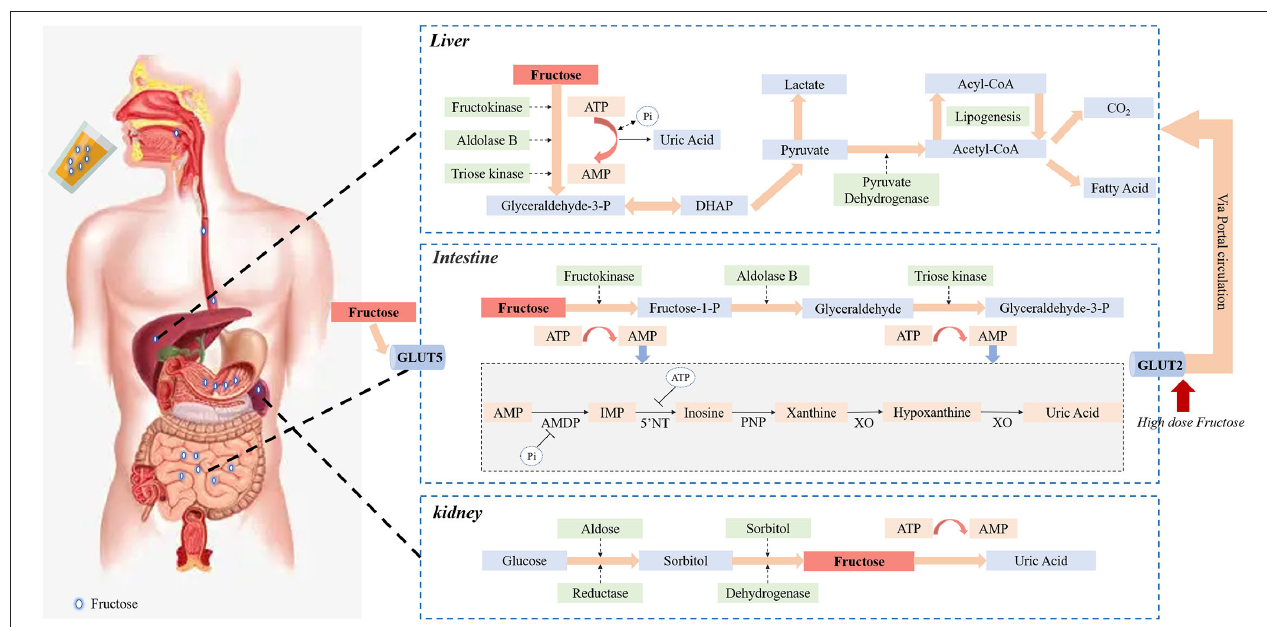
FIGURE 1 | Fructose metabolism in the body. The fructose ingested by the body will be first transported to the enterocyte via GLUT5, and then absorbed and metabolized in an insulin-independent manner. Through all the processes of metabolism in the small intestine, uric acid is produced. The rapid phosphorylation of fructose into fructose 1-phosphate requires ATP to provide a phosphate molecule, which reduces intracellular levels of ATP, GTP, and phosphate, leading to the accumulation of AMP and activation of AMP deaminase. AMP generates IMP under the action of AMP deaminase. IMP levels are elevated, which is metabolized with GMP to produce uric acid. Uric acid, in turn, inhibits AMP-activated protein kinases, which promotes more AMP metabolism through AMP deaminase, resulting in more uric acid production. The extent to which fructose enters the liver through the small intestine depends on the amount of fructose ingested. Fructose metabolism appears to be a saturation process in the intestinal, with only high doses of dietary fructose spreading to the portal circulation through the transporter GLUT2 and further extracted by the liver. Fructose and eventual metabolism in the liver produce pyruvate and acetyl-CoA, leading to adipogenesis, and the metabolic processes accompanied by rapid depletion of intracellular ATP and Pi and the production of corresponding uric acid. Renal proximal straight tubule expression of fructokinase and aldolase B is the main site of fructose metabolism under physiological conditions, continuous intake of large amounts of fructose leads to renal metabolism exceeding the threshold, resulting in a large amount of ATP depletion and inflammatory response, and finally a large amount of uric acid production and tubular damage. In addition, endogenous fructose obtained by the polyol pathway in the kidneys may be another potential mechanism for causing kidney damage and uric acid